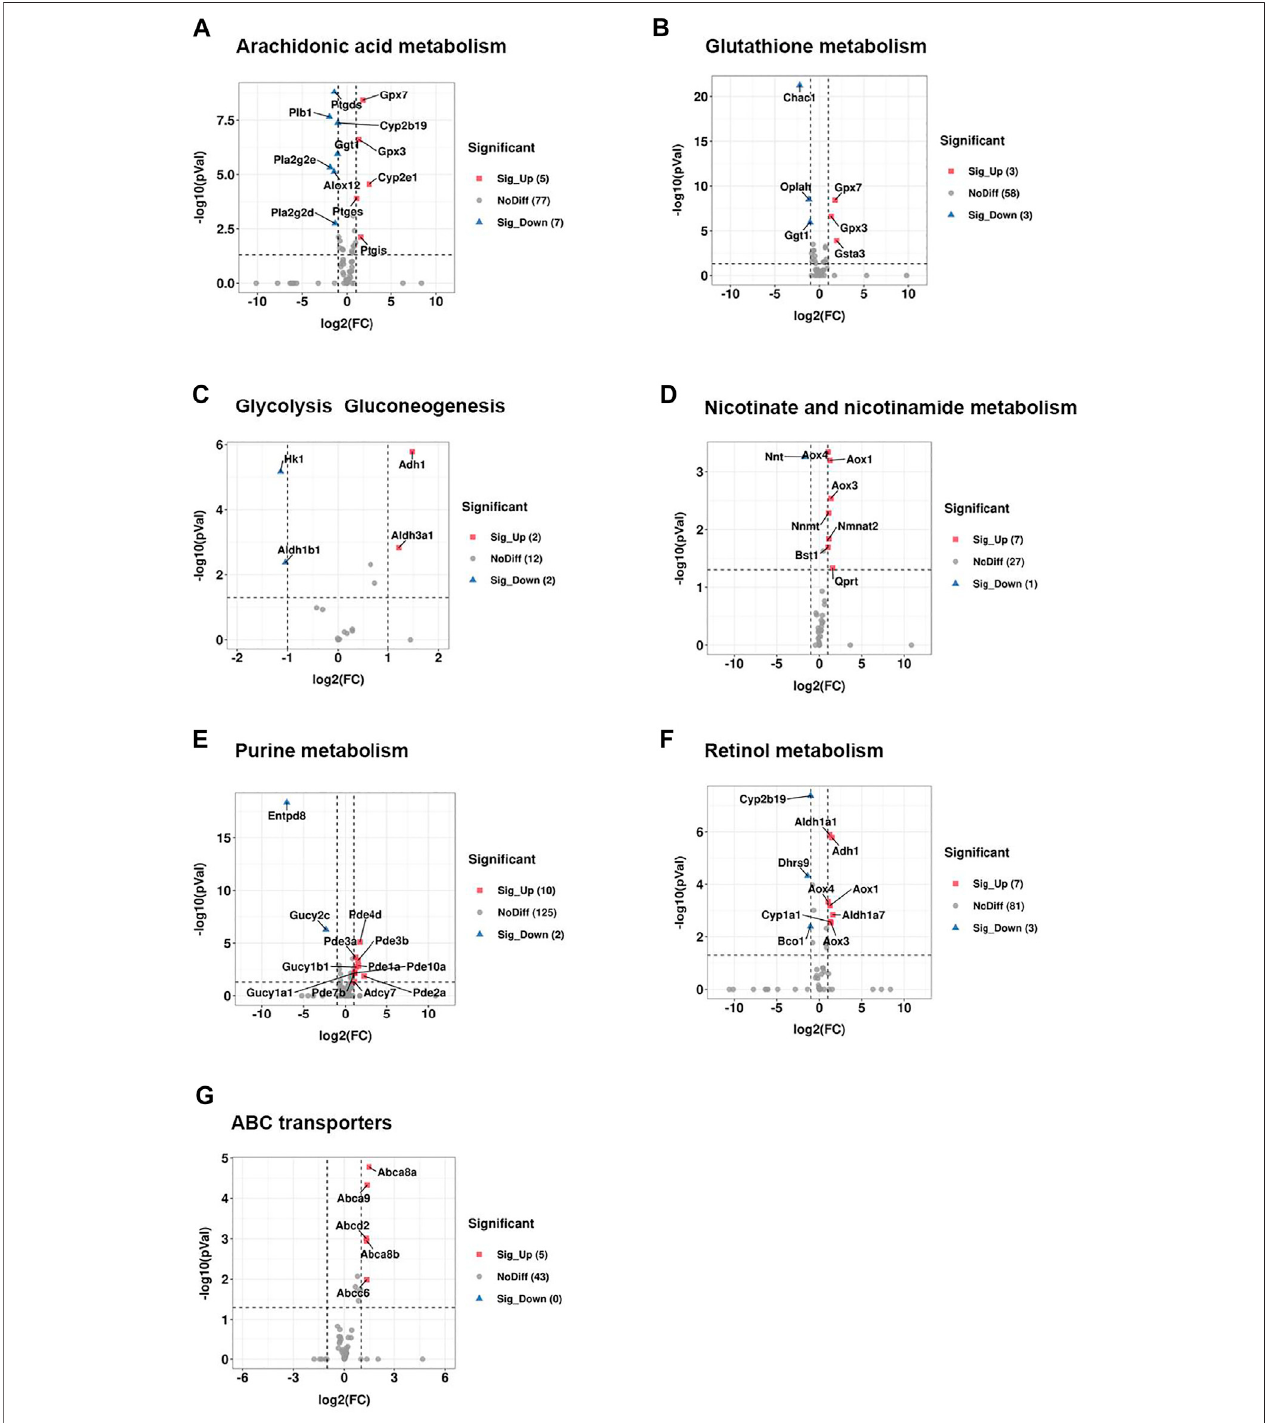
FIGURE6| CRSsigni fi cantlyaltersgenesexpressionrelatedtometabolismpathwaysbasedonRNA-seq. (A) Volcanoplotshowedregulationofgenesexpression in arachidonic acidmetabolism betweenCRSgroup andcontrolgroup. Signi fi cantlyDEGs werelabeled. FCisforgeneexpression foldchangeinCRSgroup compared to control group. The DEGs were selected with fold change > 2 or fold change < 0.5 and p value < 0.05. (B) Volcano plot showed regulation of genes expression in glutathione metabolism between CRS group and control group. (C) Volcano plot showed regulation of genes expression in glycolysis gluconeogenesis between CRS group and control group. (D) Volcano plot showed regulation of genes expression in nicotinate and nicotinamide metabolism between CRS group and control group. (E) Volcano plot showed regulation of genes expression in purine metabolism between CRS group and control group. (F) Volcano plot showed regulation of genes expression in retinol metabolism between CRS group and control group. (G) Volcano plot showed regulation of genes expression in ABC transporters between CRS group and control group.